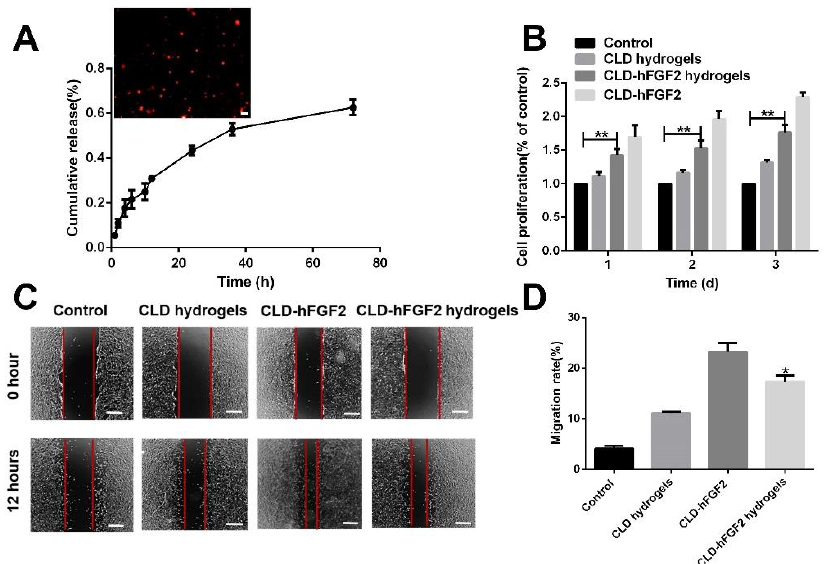
Figure 3. Cell proliferation and migration activity of CLD-hFGF2 released by hydrogels. ( A ) The CLD-hFGF2 release profiles from the hydrogels and the shape of the released CLD-hFGF2. ( B ) Fibroblast cell proliferation ability under PBS treatment. CLD was released from hydrogels, and CLD-hFGF2 and CLD-hFGF2 were released from hydrogels. ( C ) Fibroblast cell migration ability and rate of cell migration under PBS, CLD released from hydrogels, CLD-hFGF2, CLD-hFGF2 released from hydrogels. ( D ) Rate of cell migration under PBS, CLD released from hydrogels, CLD-hFGF2, CLD-hFGF2 released from hydrogels (n = 3; ** p < 0.01; scale bar = 50 μm).